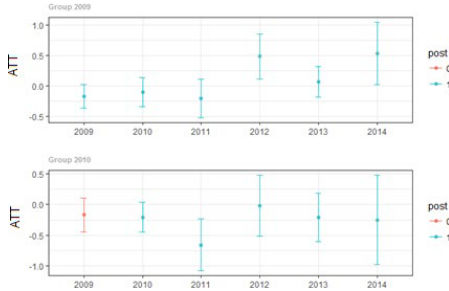
Figure 6. Group-time ATTs estimates (covariates model) – Riviera Ligure PDO